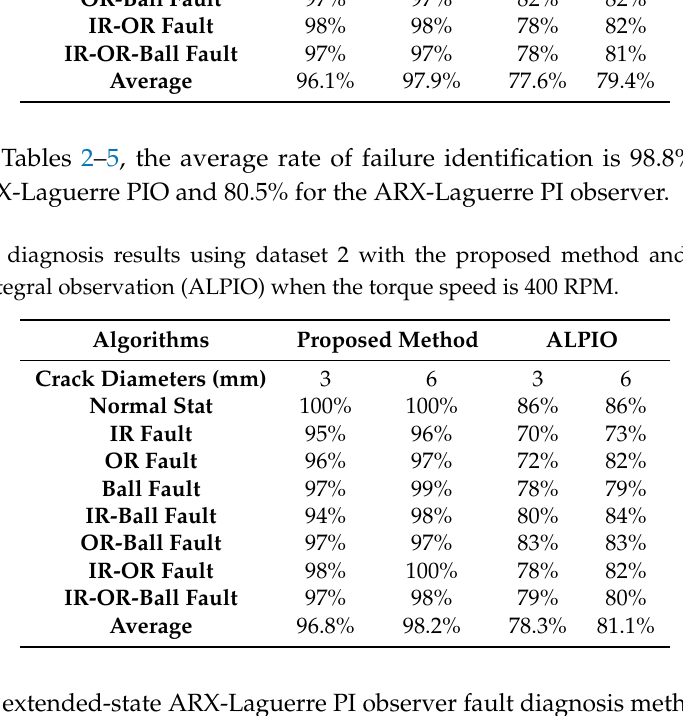
Table 2. Fault diagnosis results using dataset 1 with the proposed method and ARX-Laguerre proportional integral observation (ALPIO) when the torque speed is 300 RPM.